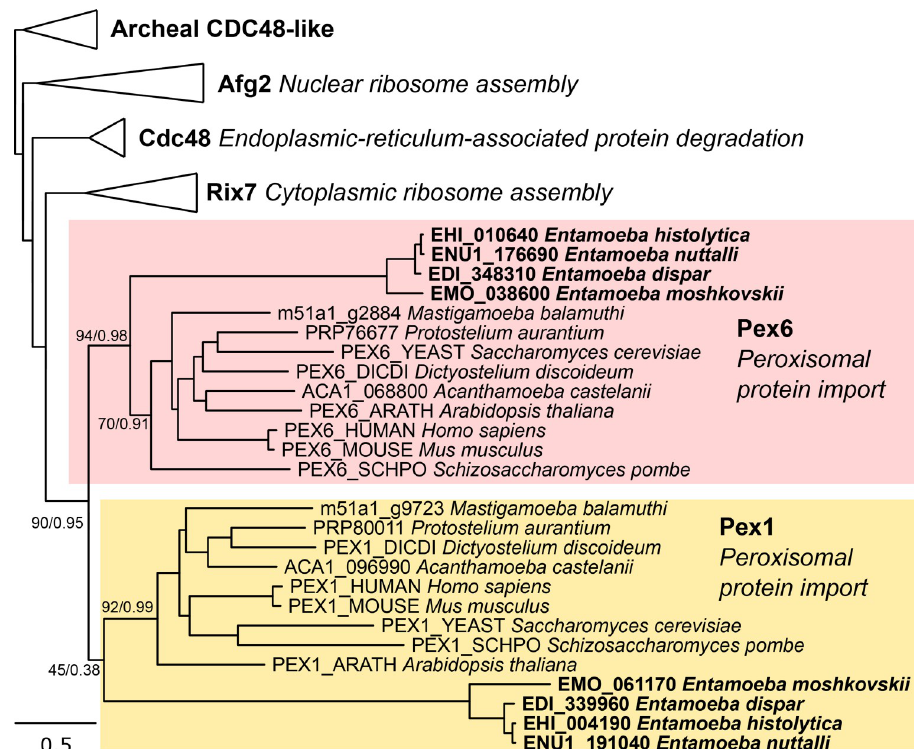
Fig 3. Phylogeny of Pex1, Pex6 and other proteins with AAA domains. The maximum likelihood tree was inferred with IQ-TREE using 51 protein sequences and 522 positions. Numbers at nodes of the tree indicate statistical support in the form of an ultrafast bootstrap of the IQ-Tree and posterior probability of the PhyloBayes analysis.